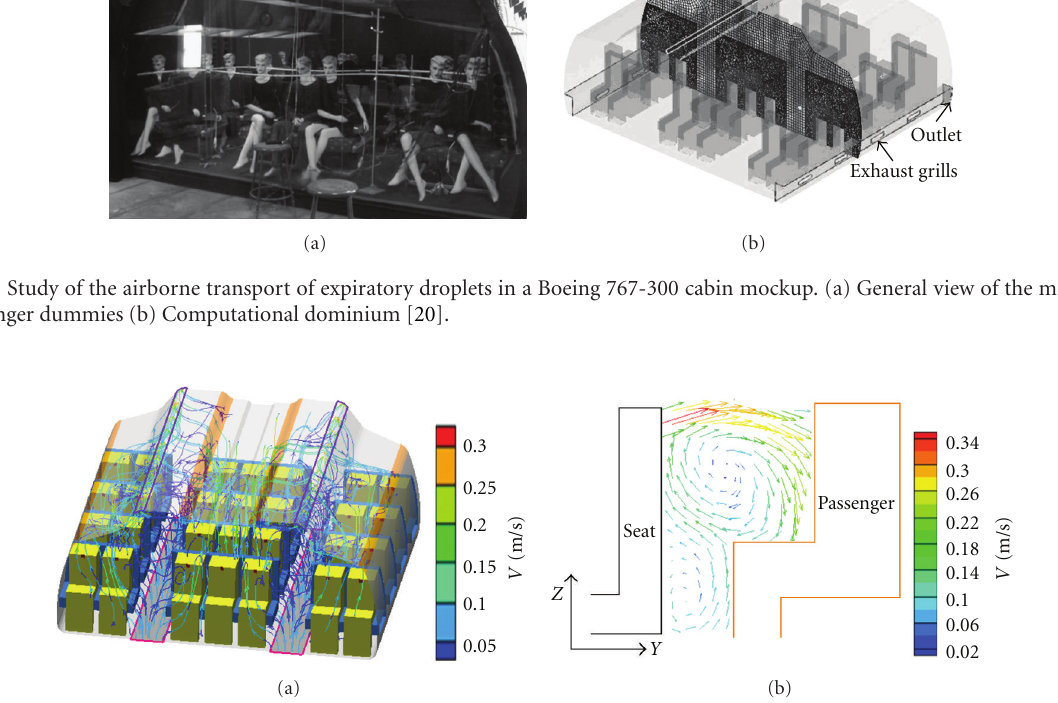
Figure 6: CFD study inside B767-300 cabin. (a) Cabin geometry. (b) PV integrated to the back of the cabin seats